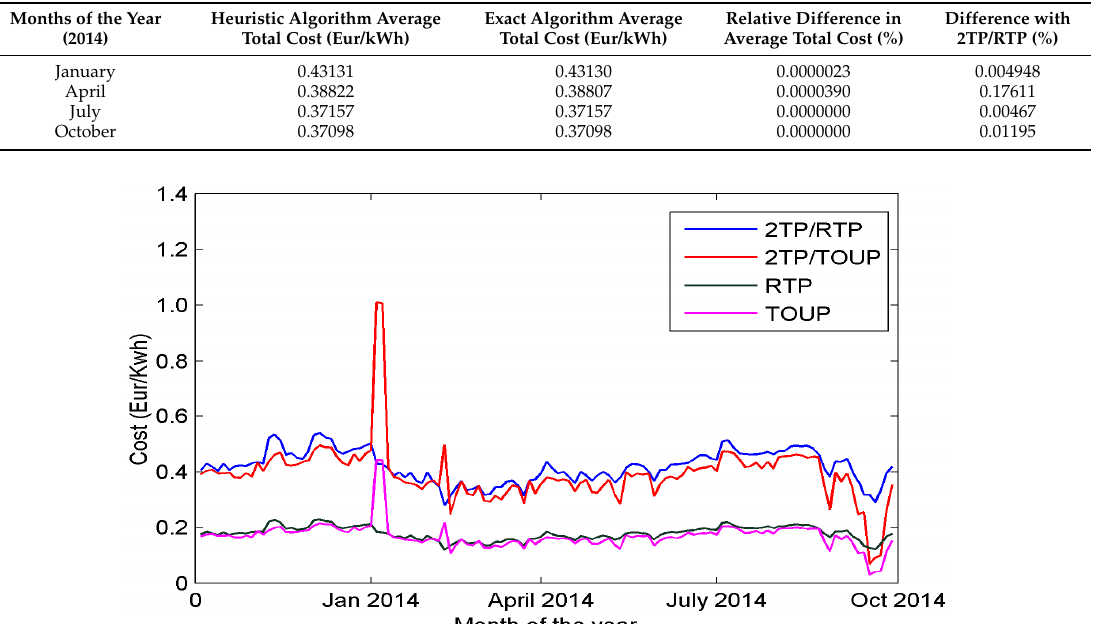
Table 4. Simulation Result of 2TP/TOUP Model across representative seasons of the year. Months of the